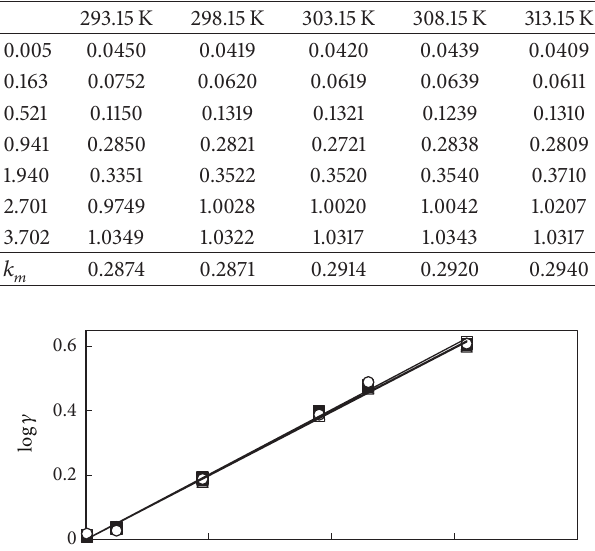
Table 8: Activity coefficients (log 𝛾 ) and the Setschenow coefficient ( 𝑘 𝑚 ) for the neutral species for L3 in aqueous KCl of different ionic strength and at different temperatures.